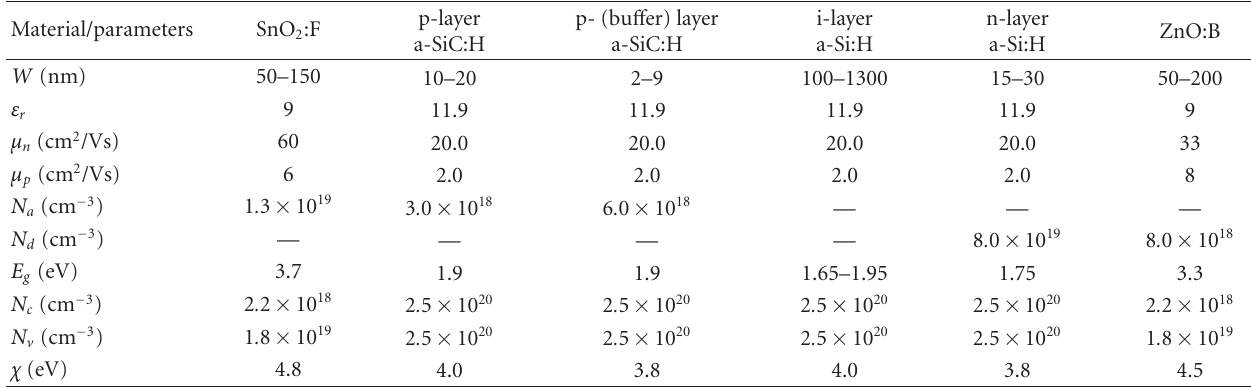
Figure 1: Schematic view of a-Si:H single-junction solar cell. Table 1: The input parameters used in modeling the single-junction a-Si:H solar cell.